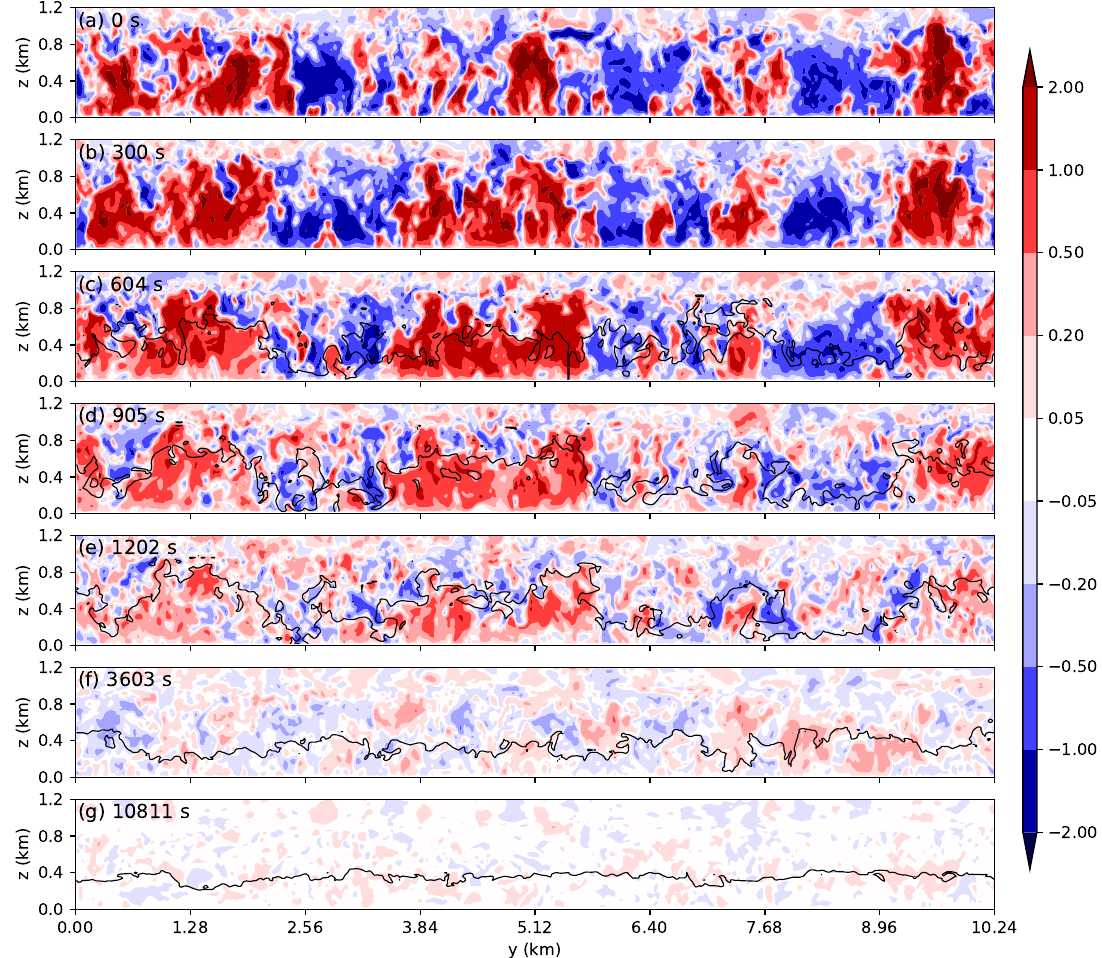
Figure 3. Vertical velocity fields at x = 1270 m and t − t c = ( a ) 0, ( b ) 300, ( c ) 604, ( d ) 905, ( e ) 1202, ( f ) 3603, and ( g ) 10,811 s. Contours of 301.51 K potential temperature are added in ( c – g